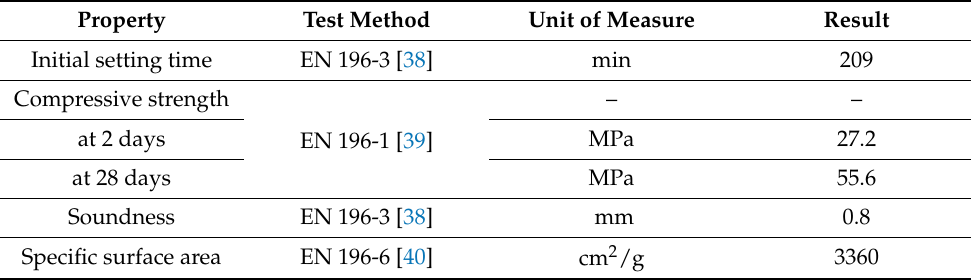
Table 4. Properties of Portland cement CEM I 42.5R.